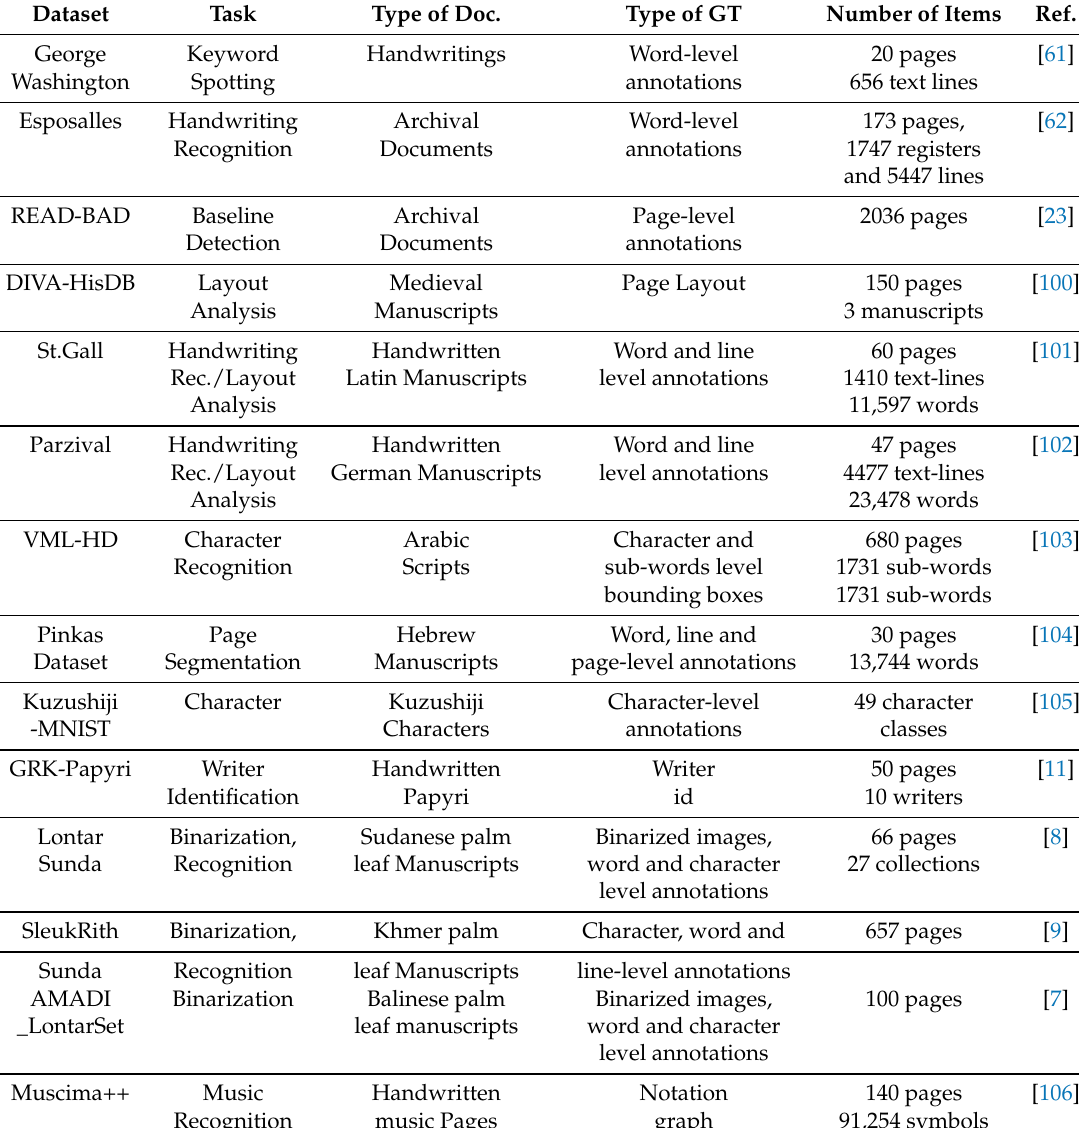
Table 3. Features of main datasets used in historical document image